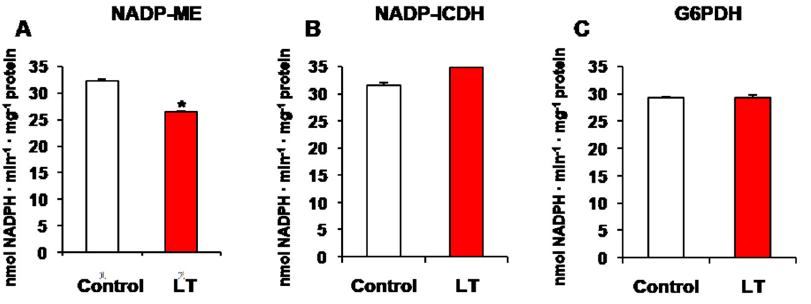
Figure 2. Activity of NADP-dehydrogenase enzymes of the 14-day-old Arabidopsis seedlings grown in MS medium subjected to low temperature (LT) for the last 48 h. ( A ) NADP-malic enzyme (NADP-ME). ( B ) NADP-isocitrate dehydrogenase (NADP-ICDH). ( C ) Glucose-6-phosphate dehydrogenase. The results are the mean of at least three different experiments + SEM. * Differences in relation to the control values were significant at p < 0.05. NADP: nicotinamide-dinucleotide phosphate.